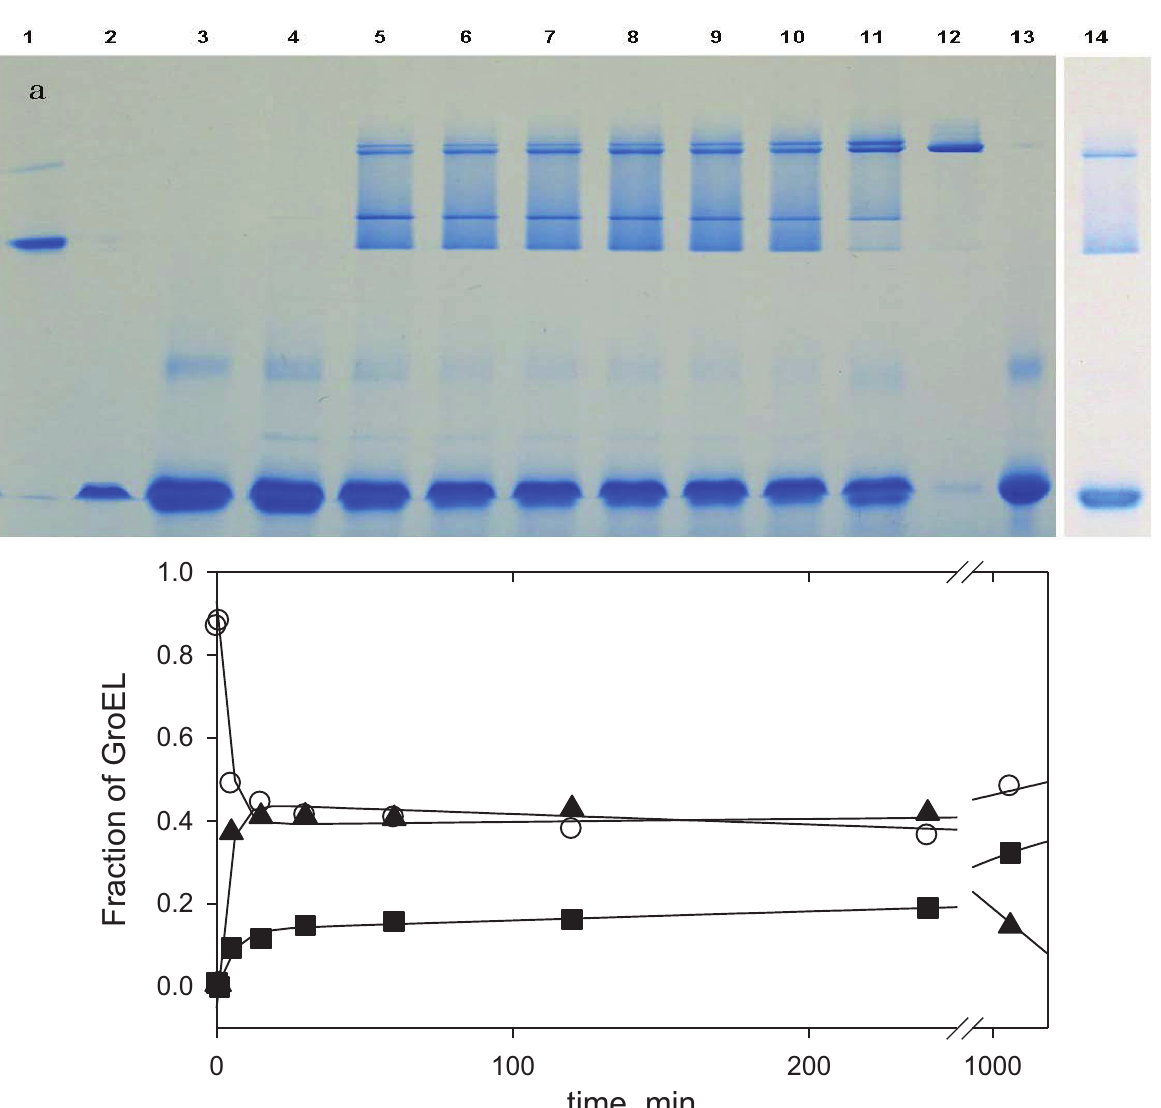
Figure 8. Nondenaturing blue electrophoresis analysis of GroEL oligomerization kinetics: a — the products of GroEL oligomerization kinetics visualized by Coomassie brilliant blue G250 (slots: 1 — SR1 one ring mutant of GroEL, 2 — GroES heptamer, 3 — 60 min after GroEL oligomerization reaction was started in the presence of Coomassie brilliant blue G250 dye, 4 — 1 min, 5 — 5 min, 6 — 15 min, 7 — 30 min, 8 — 60 min, 9 — 120 min, 10 — 240 min and 11 — 1200 min after the GroEL oligomerization reaction started in the presence of Mg-ATP and two molar excess of GroES, 12 — GroEL tetradecamer, 13 — GroEL monomer, 14 — 180 min after the GroEL oligomerization reaction was started in the absence of GroES); b — the time-resolved change of GroEL monomer ( ○ ), intermediate oligomer ( ▲ ) and full-size GroEL particle (■) during the GroEL oligomerization reaction in the presence of GroES and Mg-ATP. The data were obtained by an analysis of electrophoretic band intensities (Figure 8a) using the computer program TatalLab TL120 1Dv 2009 (Nonlinear Dynamics Ltd., Newcastle upon Tyne, UK). Intensities of the bands corresponding to the intermediate oligomer, the full-size GroEL, and their complexes with GroES were summarized and represented as the intermediate oligomer ( ▲ ) and the full-size GroEL particle